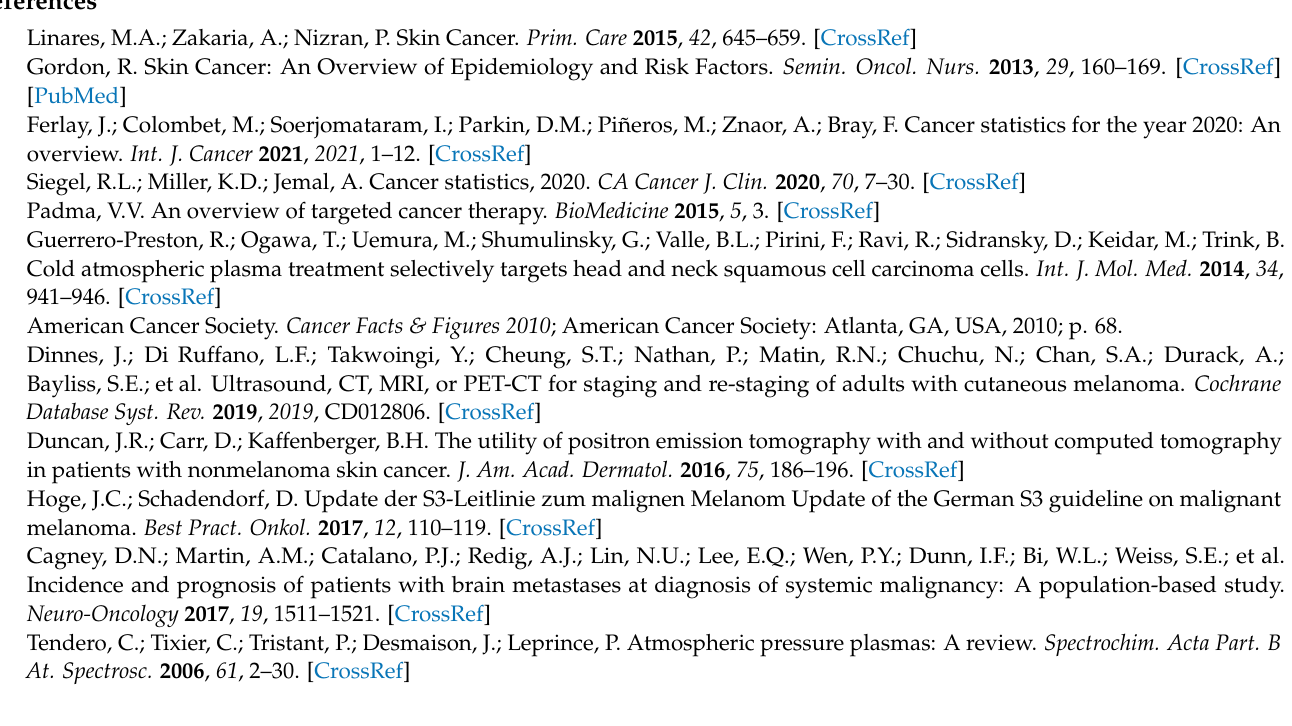
Figure S2. Original western blot